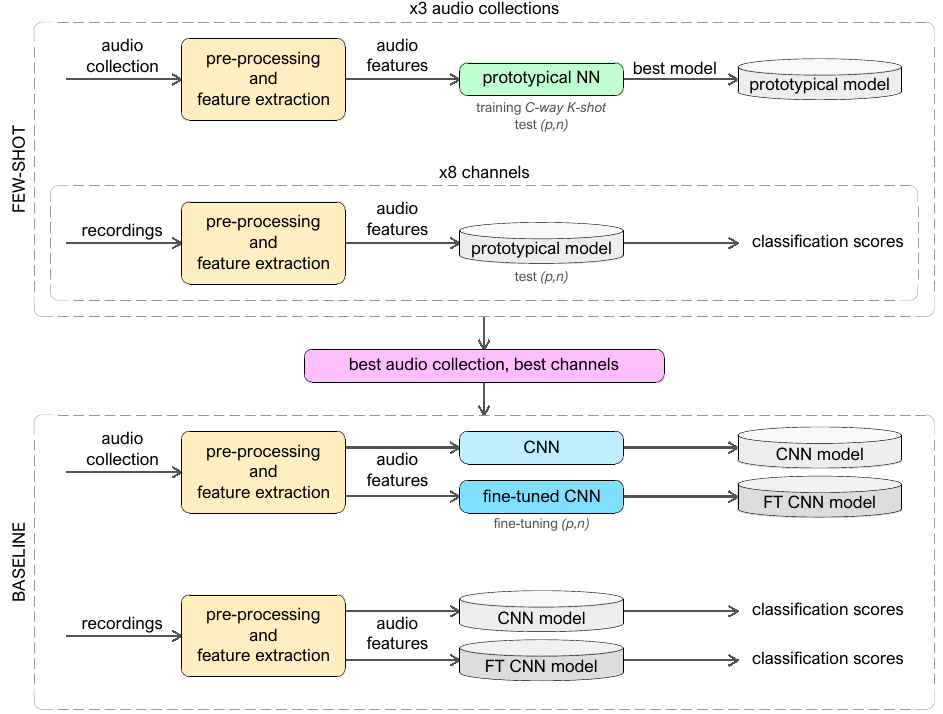
Figure 3. The block diagram of the proposed approach for emergency siren